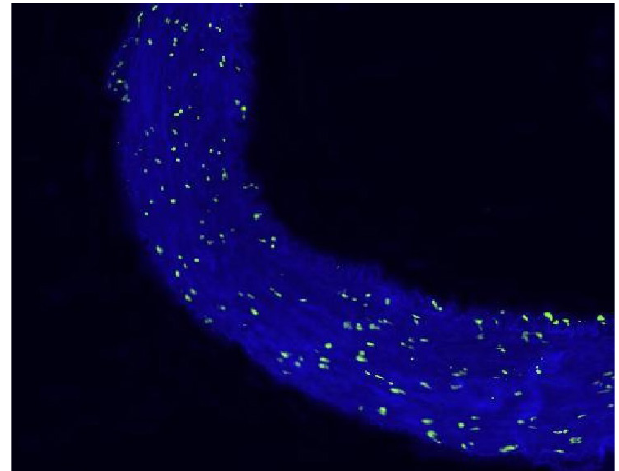
Fig. 2B - Terminal deoxynucleotidyl transferase-mediated dUTP- biotin nick end labeling (TUNEL) stain of an artery in the diltiazem group (Group D).